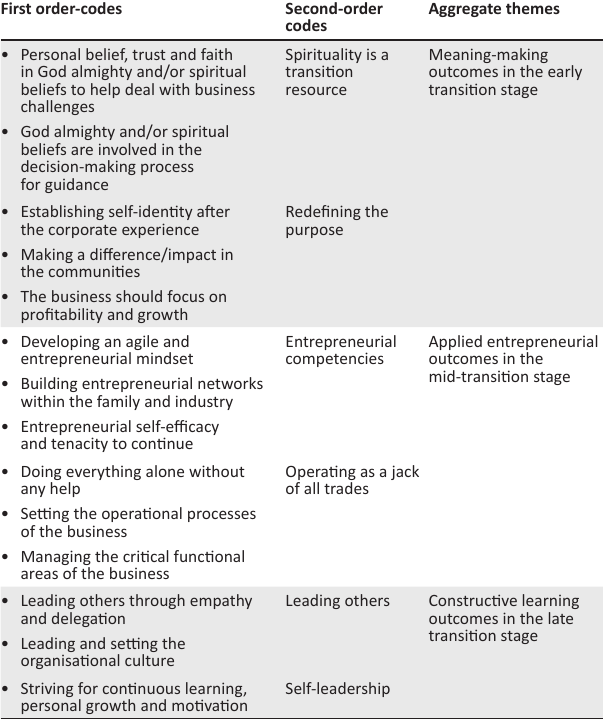
FIGURE 2: The transitioned business TABLE 3: Learning outcomes in the transition from hybrid to the full-time entrepreneurship.